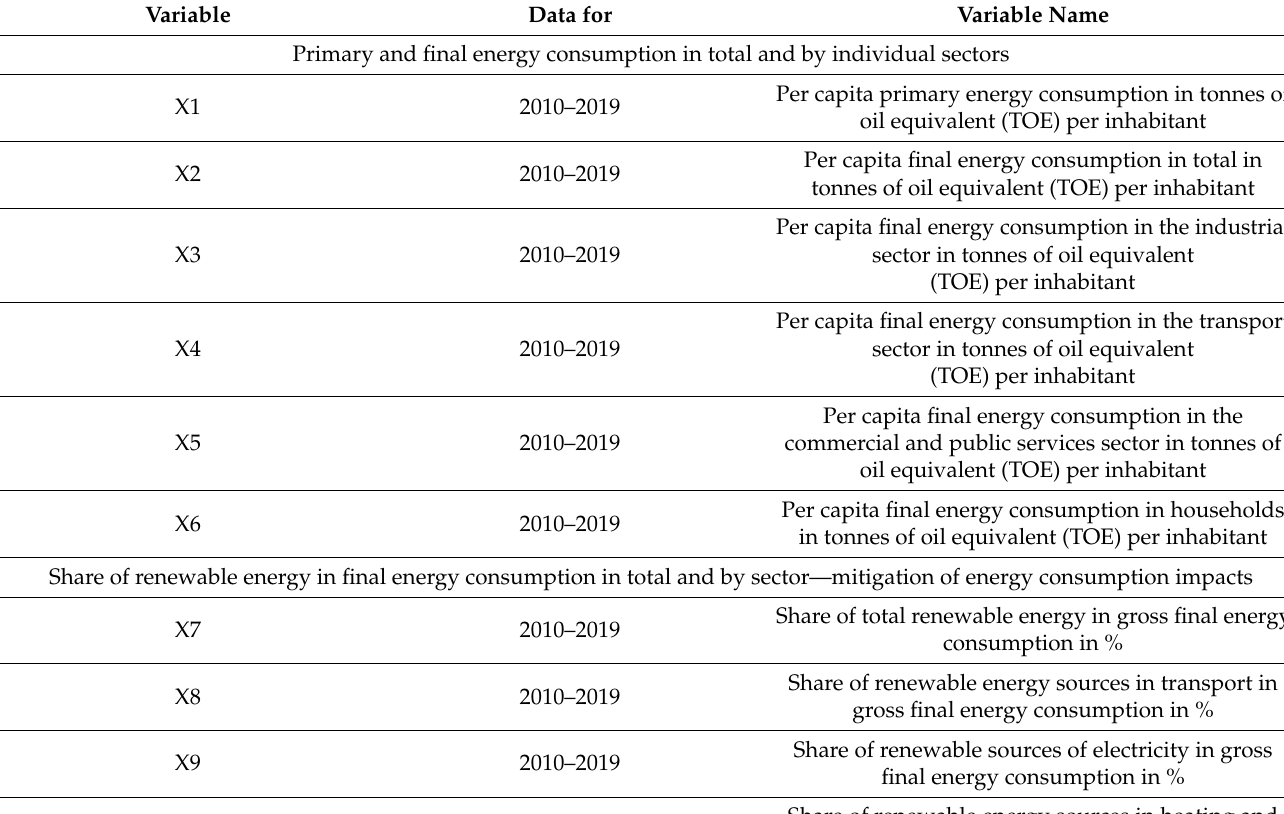
Table 1. Indicators allowed for in the study of energy consumption in total and by individual sectors, renewable sources of energy, environmental impacts and economic conditions in EU (27) countries in